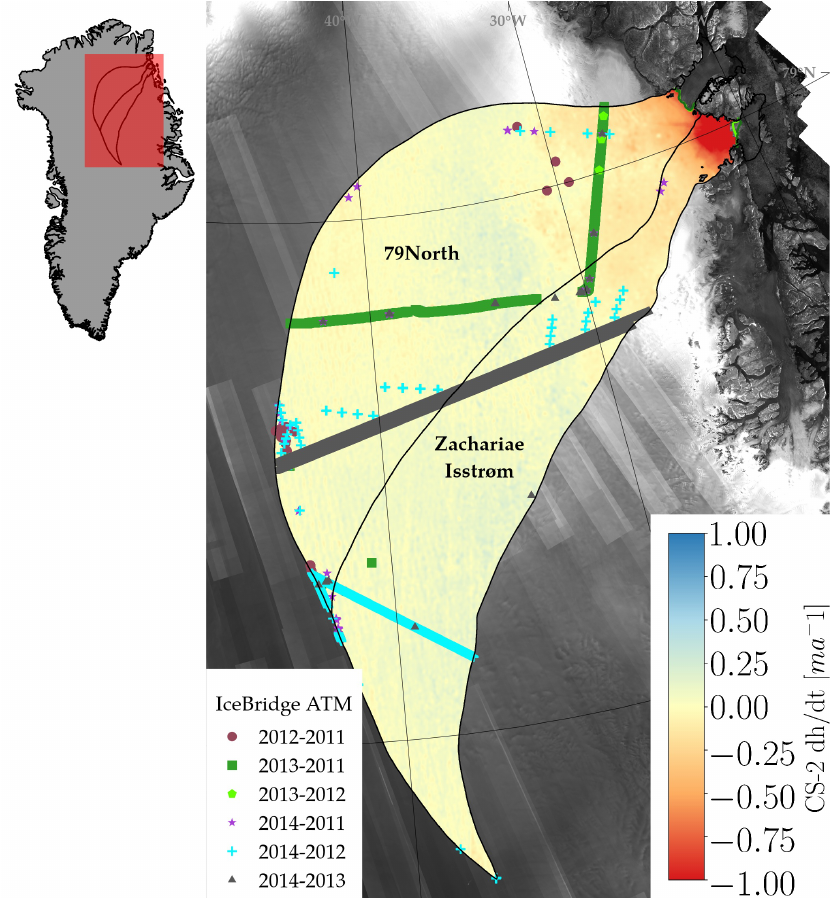
Figure 3. Surface elevation change rates for Zachariæ Isstrøm and 79North measured by CS-2 RAA from January 2011 to January 2014 and superimposed footprints of IceBridge ATM overflights. A detailed comparison to the IceBridge ATM data can be found in Section 4. In the background is the TDM global DEM backscattering